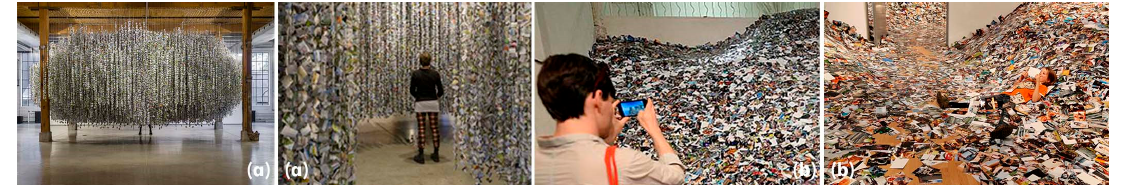
Figure 2. ( a ) Mémoires by Roberto Pellegrinuzzi; ( b ) 24 Hours in Photos by Eric